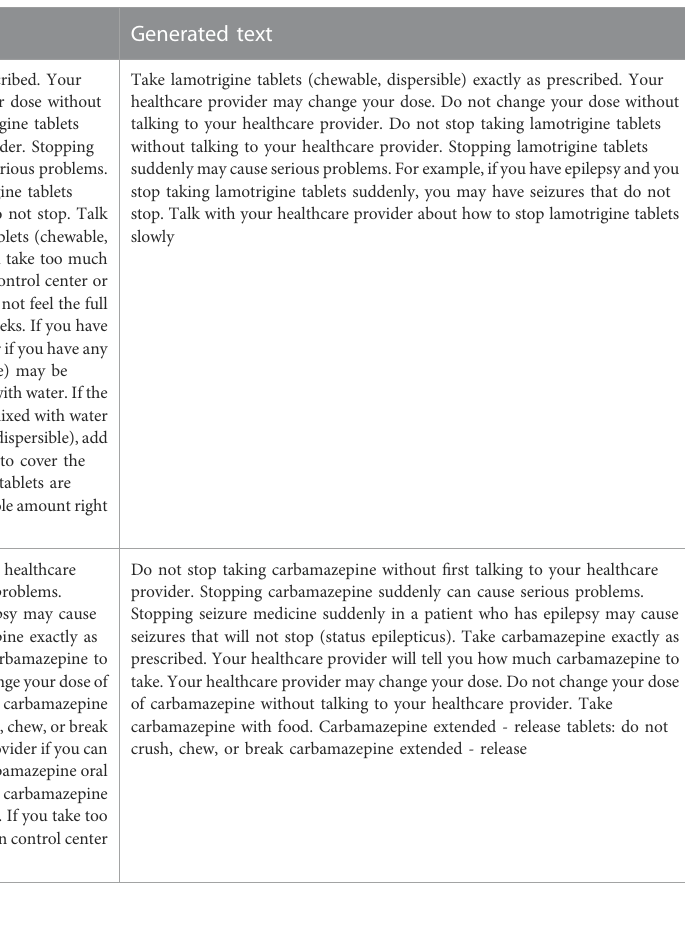
TABLE 5 Heuristic alignment